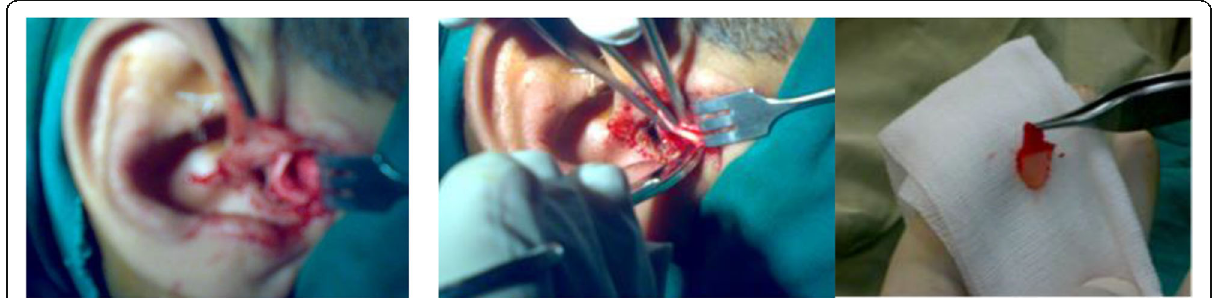
Fig. 2 Tragal cartilage harvested through skin incision on medial side of tragus, cartilage with attached perichondrium dissected medially, and cartilage-perichondrium graft was prepared by elevating the perichondrium over convex surface of the